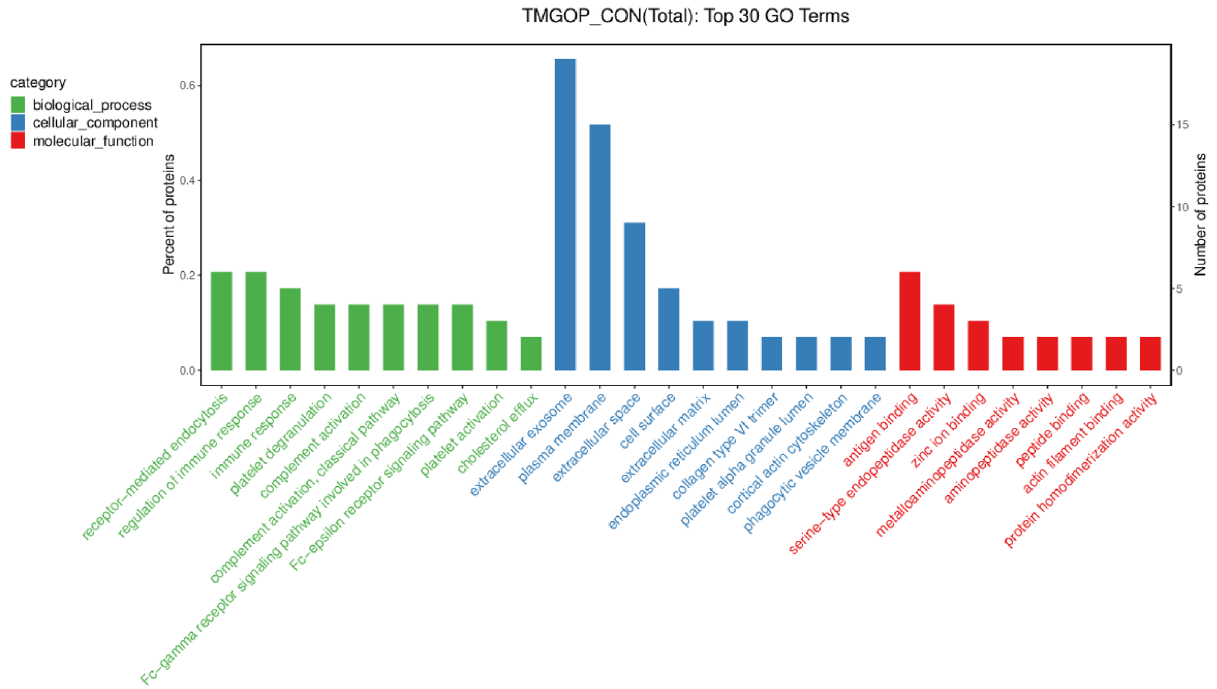
Figure 5. GO annotation and enrichment analysis. In the figure, the x-coordinate represents the name of the GO entry, while the y-coordinate shows the number of proteins and their percentage in relation to the corresponding